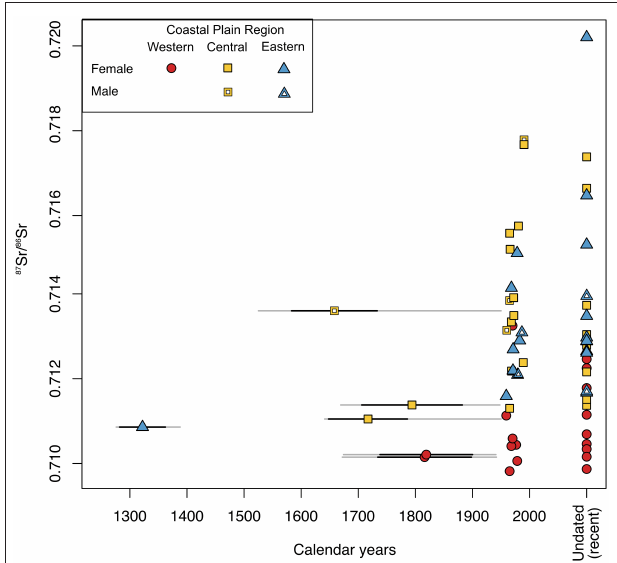
FIGURE 4 | Timeseries of 87 Sr/ 86 Sr for female and male caribou antlers from the Western, Central, and Eastern Coastal Plain. Antler ages (calendar years) are calibrated AMS dates. For antlers shed prior to the 1950s, calibrated radiocarbon ages are illustrated as the weighted mean (points), total age range (gray horizontal lines), and 1-sigma around the mean (black horizontal lines) of the 95% confidence interval. For antlers shed after the 1950s, calibrated dates are summarized as the year with the highest posterior probability of the calibration (points); dating errors for these antlers are too small to be shown but are available in Supplementary Table 2